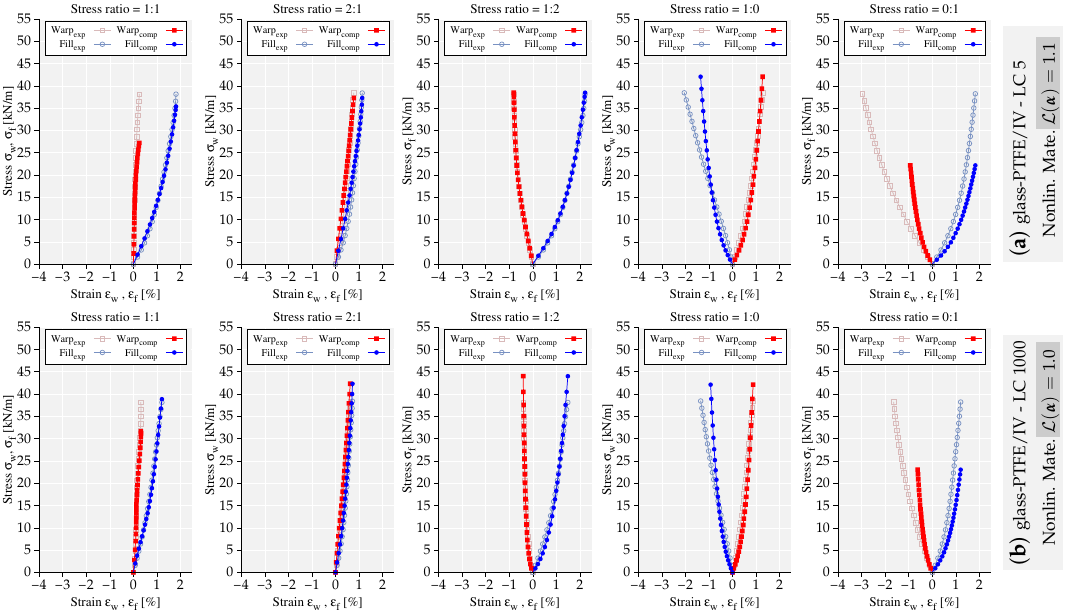
Figure 3. Mechanical response of the nonlinear material model fitting the stress–strain paths of glass-PTFE/IV ( a ) load cycle (LC) 5, ( b ) LC 1000. The obtained error value each